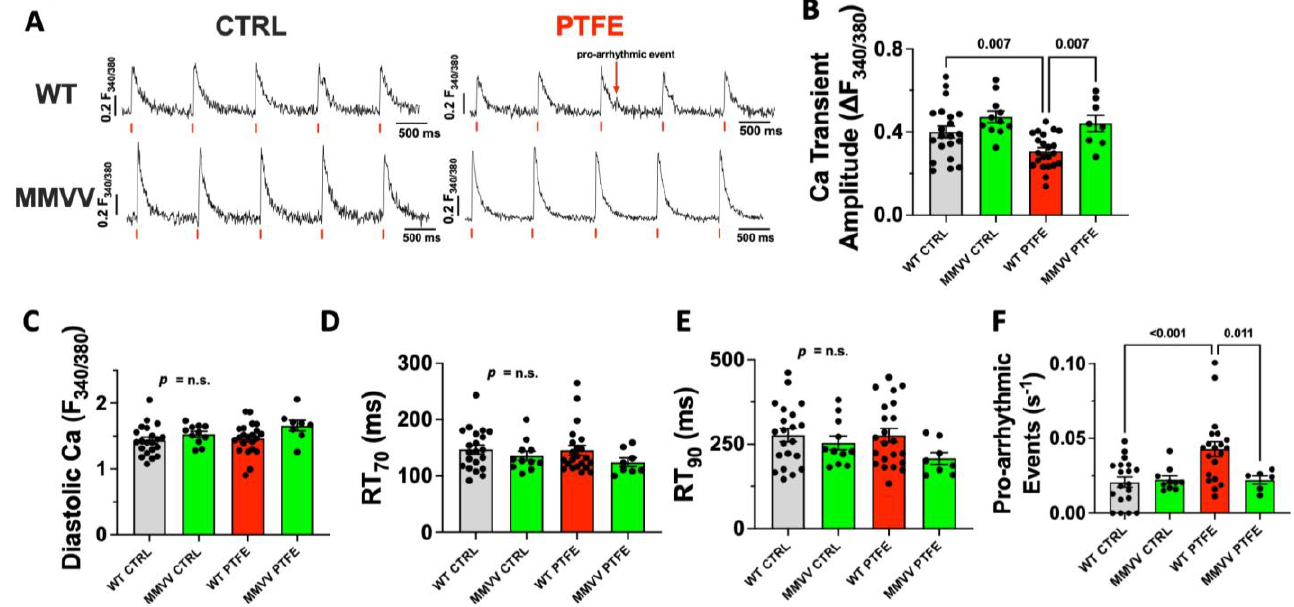
Figure 4. ( A ) Original Ca transients recorded in Fura-2 AM loaded isolated ventricular cardiomyocytes (1 Hz). The red arrow indicates a non-stimulated pro-arrhythmic event in a WT PTFE cell. ( B ) Mean Ca transient amplitude, diastolic Ca ( C ), relaxation time to 70% ( D ) and 90% of baseline ( E ) per animal ( n = 21 WT CTRL, n = 11 MMVV CTRL, n = 22 WT PTFE, n = 8 MMVV PTFE). ( F ) Frequency of non-stimulated pro-arrhythmic events (as in ( A ), n = 19 WT CTRL, n = 10 MMVV CTRL, n = 20 WT PTFE, n = 6 MMVV PTFE). Statistical comparisons are based on ANOVA with Holm – Sidak ’s post hoc correction.